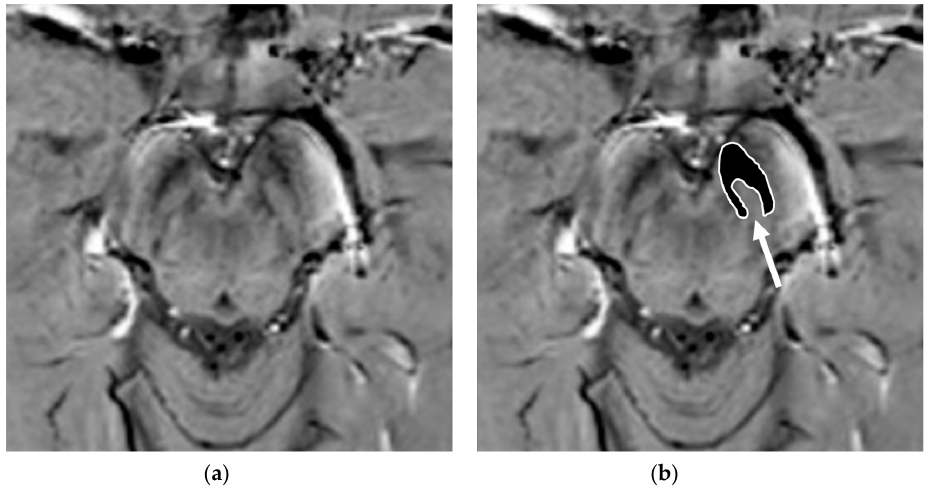
Figure 3. Susceptibility-weighted imaging (SWI) scan performed with a 3T MR scanner in a normally aging brain of a 65-year-old male who underwent a brain MRI examination for persistent headaches. A raw slice passing through the mesencephalon ( a ) and the same slice with superimposed highlighted SNc (white surrounded black ROI), thereby demonstrating the normal appearance of the nigrosome-1 (hyperintense area pointed by the white arrow) or swallow-tail sign ( b